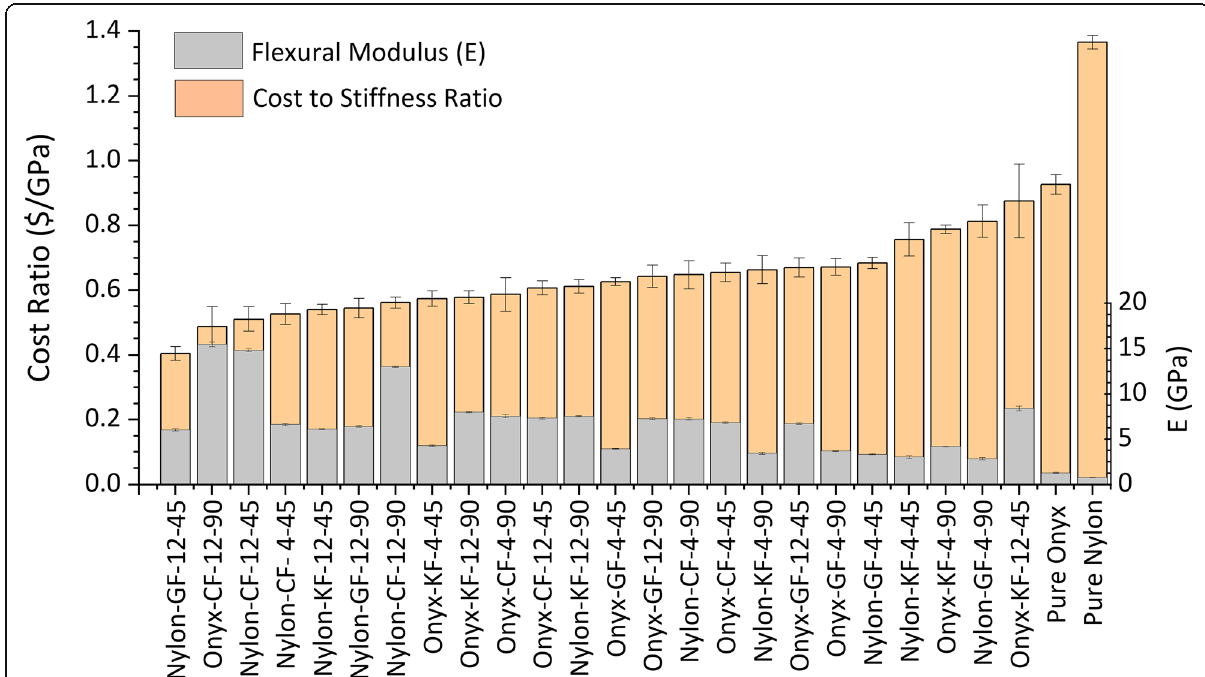
Fig. 10 Cost Ratio ($/GPa) and E for Composites and Un-reinforced